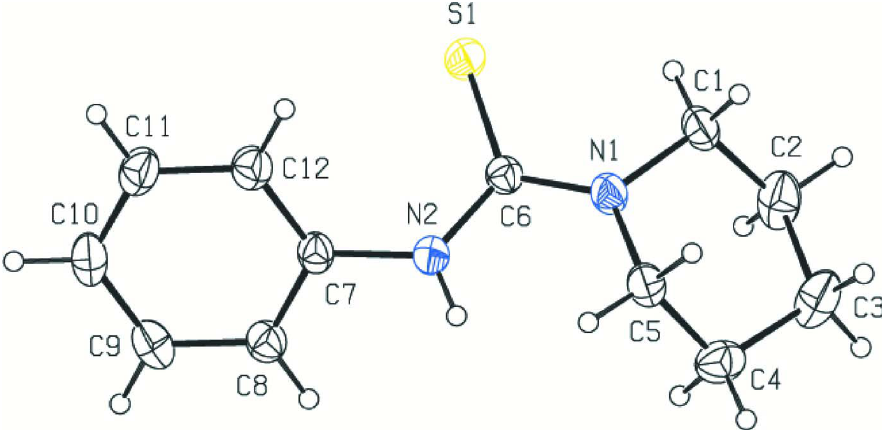
The structure of the title compound showing 30% probability displacement ellipsoids and the atom-numbering